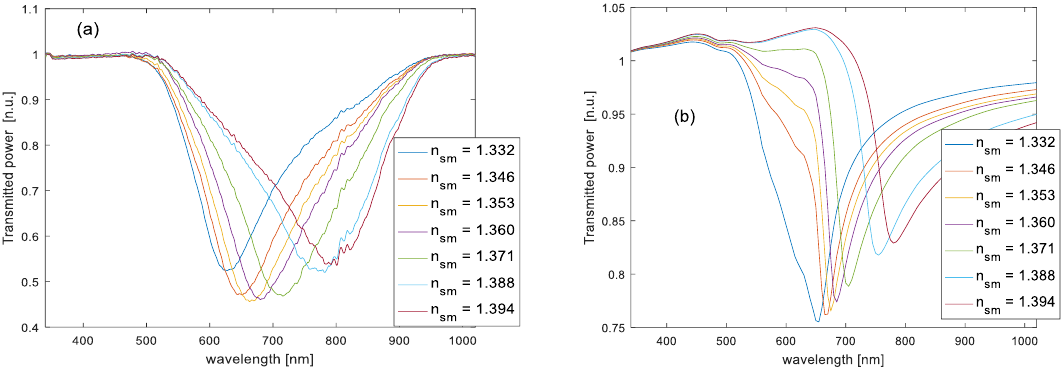
Figure 4. Experimental ( a ) and numerical ( b ) SPR spectra obtained after normalization to the transmission spectrum in air.